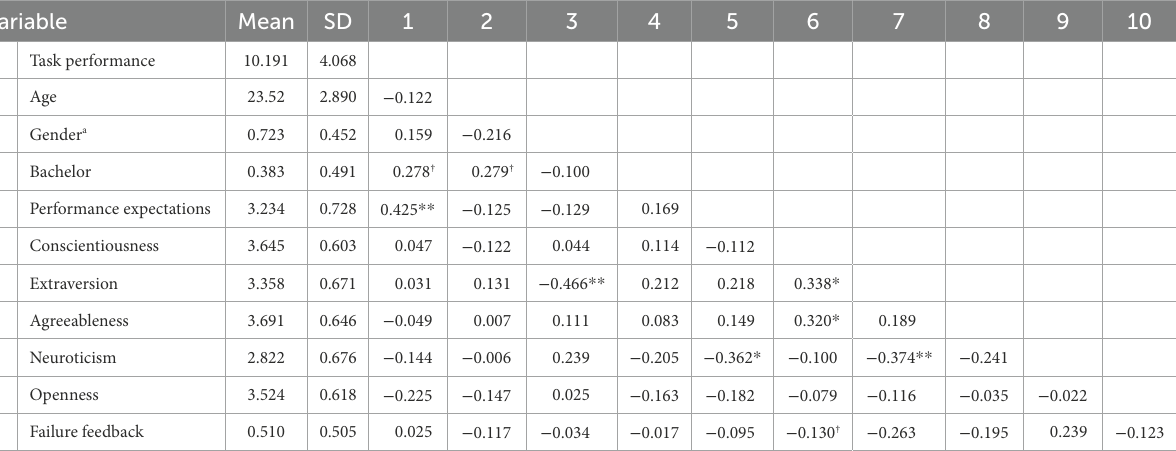
TABLE 1 Means, standard deviations, and